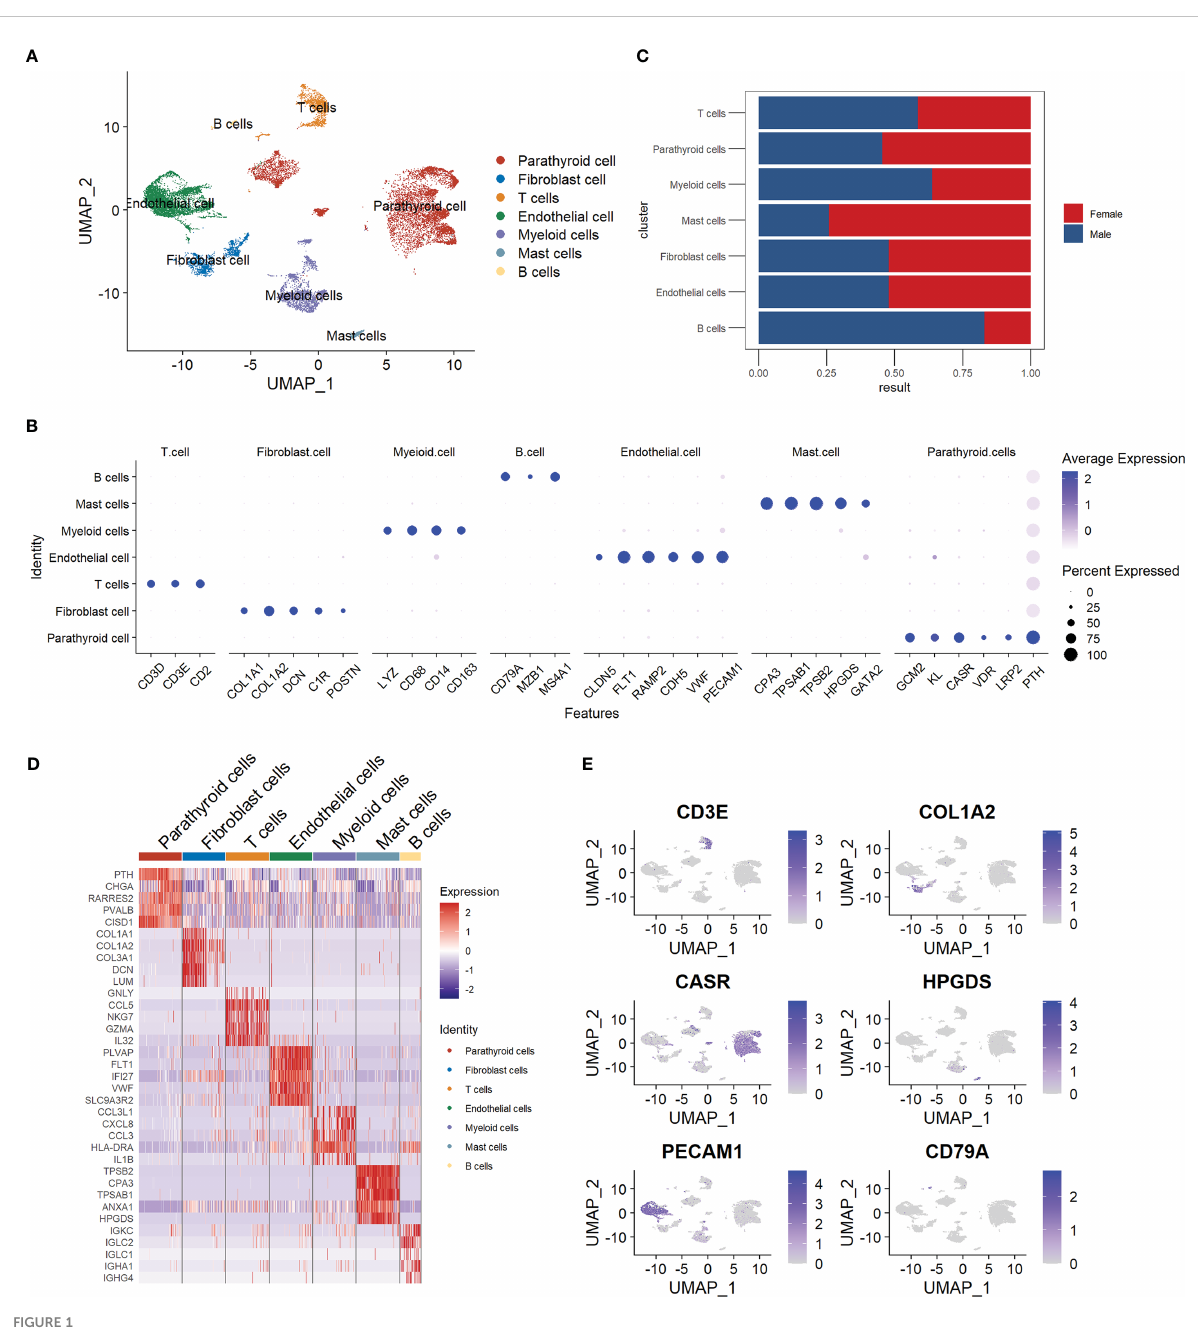
pathway is identi fi ed as the most activated pathway. As shown in Figure 3G, fi broblast cells and endothelial cells are the major cell types that send regulatory signals through the FGF pathway to themselves, as well as to the parathyroid cells. In Figure 3H, we show in detail the sender-receiver interactions between FGFs and FGFRs in different cell types and sexes. It can be observed that the FGF7-FGFR1 and FGF7-FGFR2 communications from fi broblast cells to parathyroid cells show higher probabilities in females than in males, which might be associated with the sex differences.